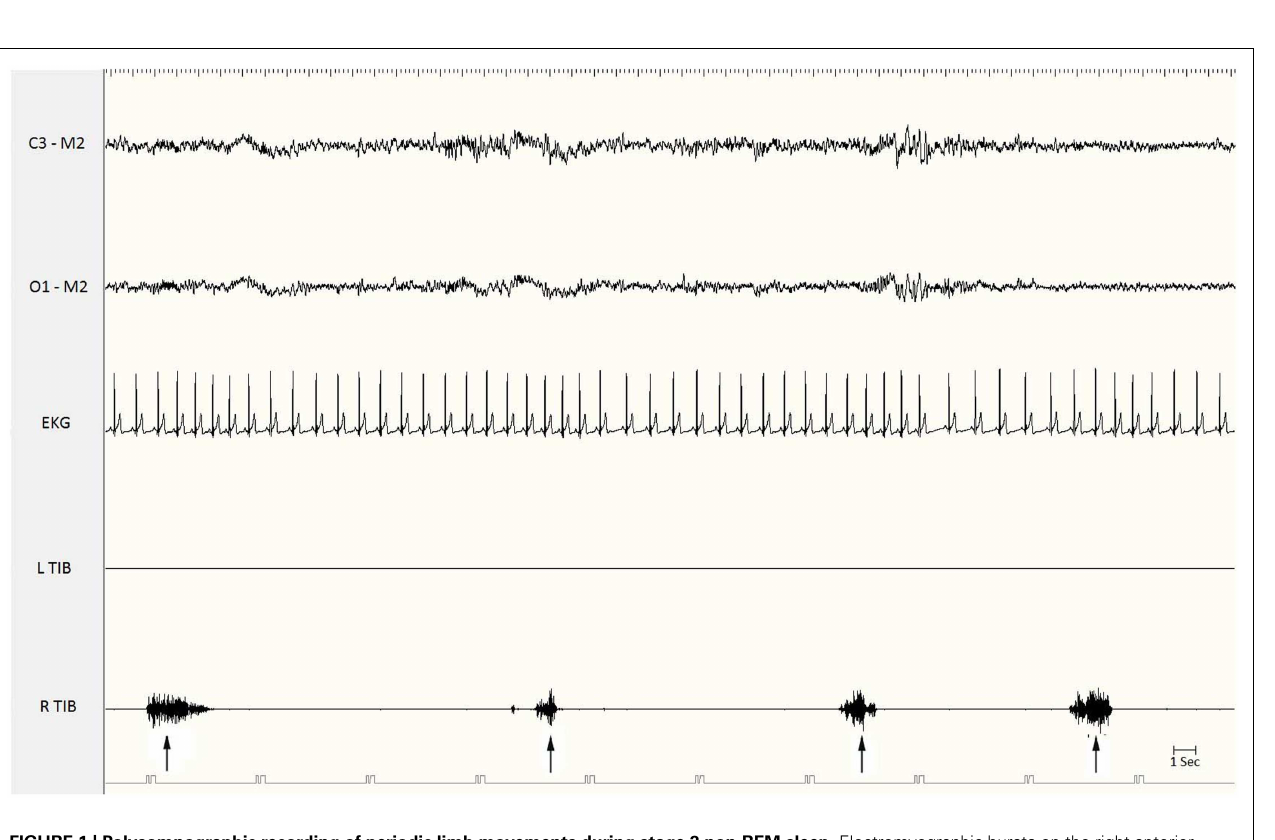
FIGURE 1 | Polysomnographic recording of periodic limb movements during stage 2 non-REM sleep . Electromyographic bursts on the right anterior tibialis muscle (R.Tib) recur periodically every 15–20s (see the arrows). EKG, electrocardiogram;Tib, tibialis anterior; R, right; L,